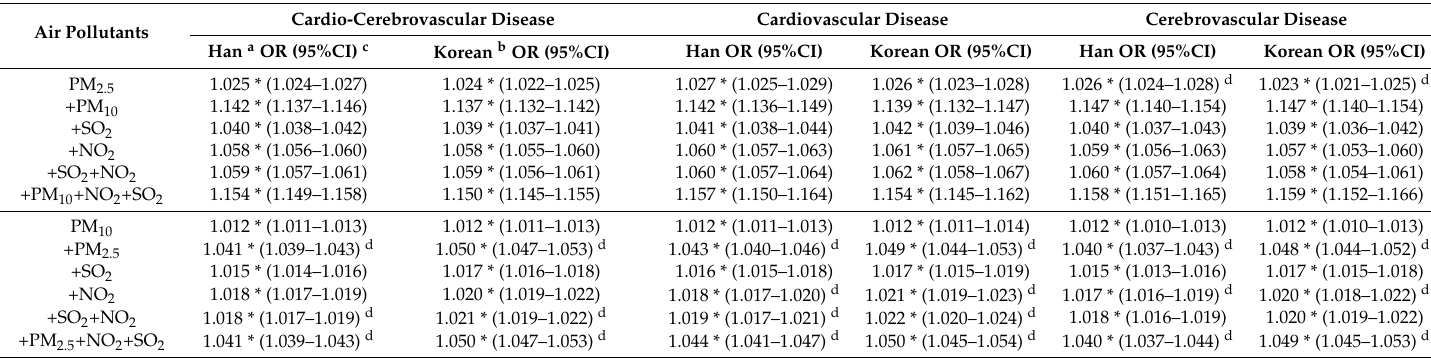
Table 4. OR value of cardio-cerebrovascular disease mortality associated with 10 µ g/m 3 increase of PM 2.5 and PM 10 in multiple-pollutant models for ethnic Korean Chinese and ethnic Han Chinese in Yanbian North Korea Autonomous Prefecture,